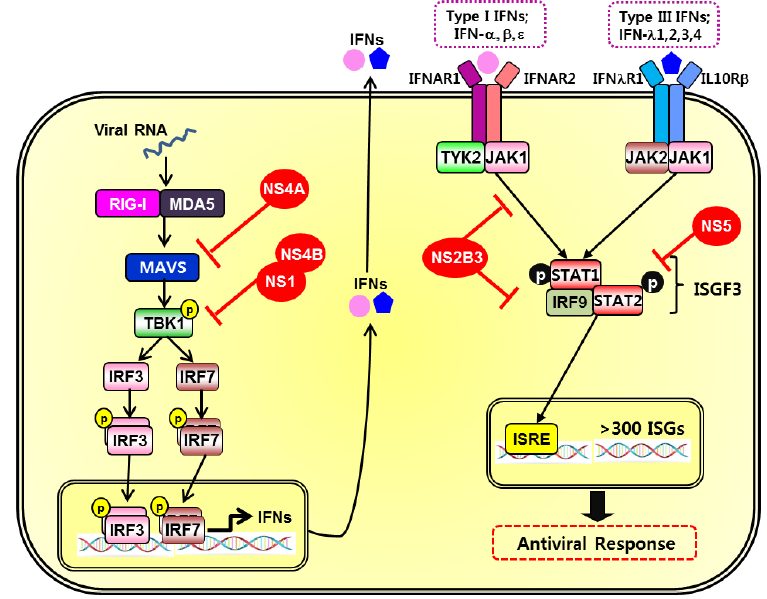
Figure 2. Innate immune evasion mechanisms by ZIKV. During ZIKV infection, viral RNA sensors and interferon-mediated signaling through downstream adaptor molecules and transcription factors can be targeted for immune evasion strategies. Viral proteins, indicated by red color, can interfere with interferon (IFN) responses by suppressing the induction of signaling pathways at multiple steps [26,71,98 – 102].